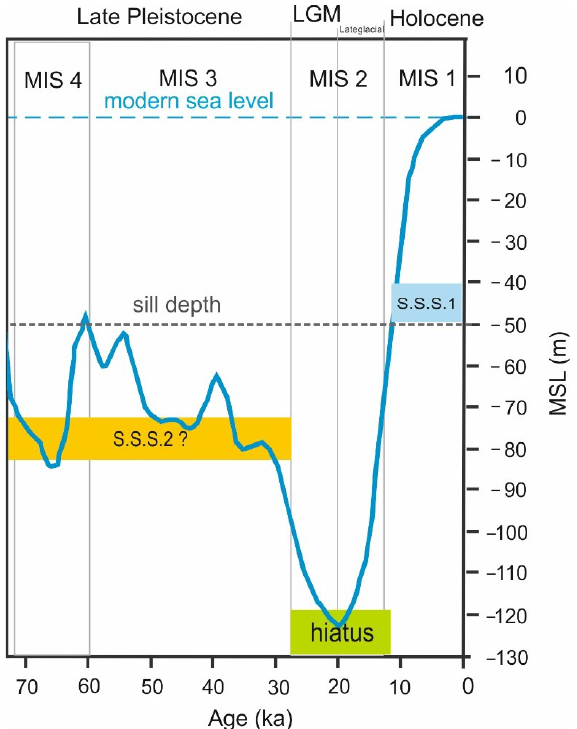
Figure 16. Seismostratigraphic sequences correlated with the Late Pleistocene–Holocene sea-level curve (modified from